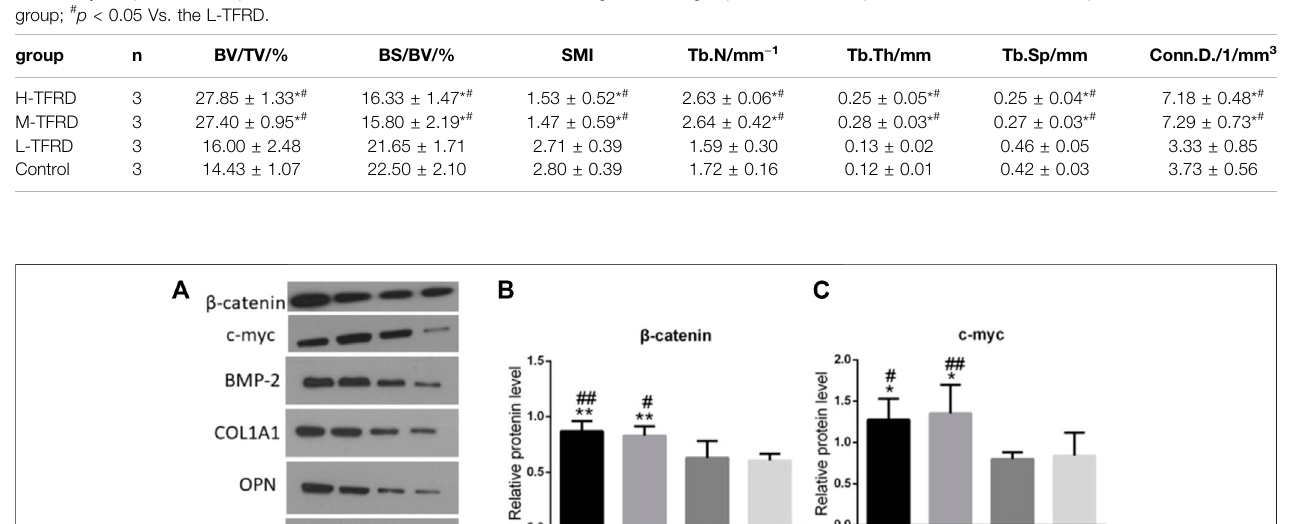
Frontiers in Pharmacology |